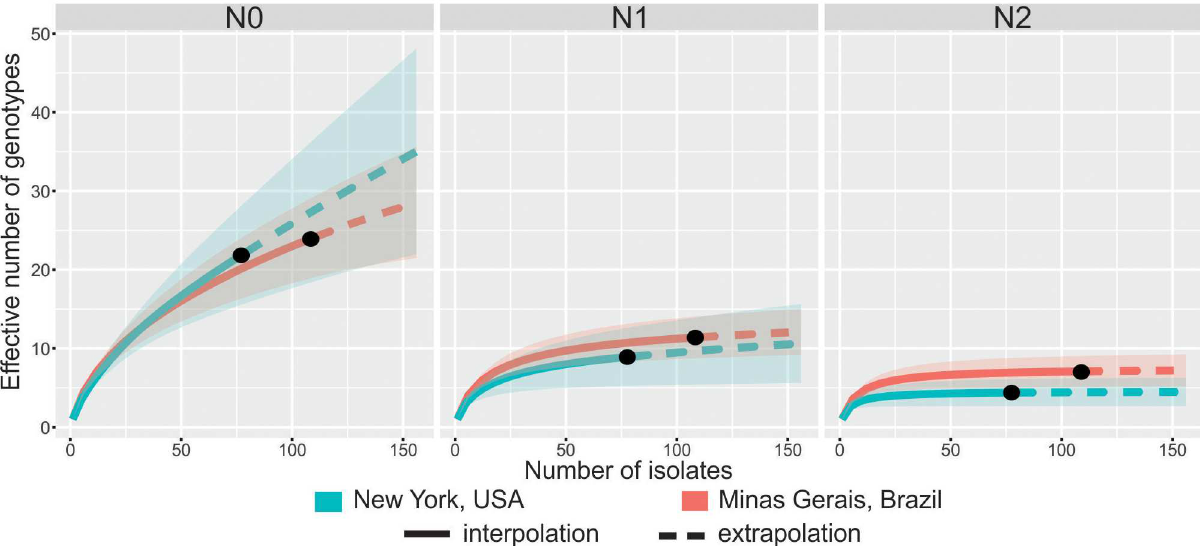
Fig 2. Diversity accumulation curves for different sample sizes with 95% confidence intervals (shaded areas) of the Hill’s numbers or effective number of genotypes of orders 0 (N0), 1 (N1) and 2 (N2) estimated for the Sclerotinia sclerotiorum populations from New York, USA and Minas Gerais, Brazil. The N0, N1 and N2 numbers correspond to genotyperichness, the exponential of Shannon’s entropy, and the inverse of the Simpson’sconcentration indices, respectively.Solid lines correspond to rarefaction (interpolation) and dashed lines to extrapolation curves up to the base sample size of 156 individualswhich corresponds to doublethe smaller reference sample size (NY = 78). The 95% confidenceintervals were obtained by a bootstrapmethod based on 200 replications.